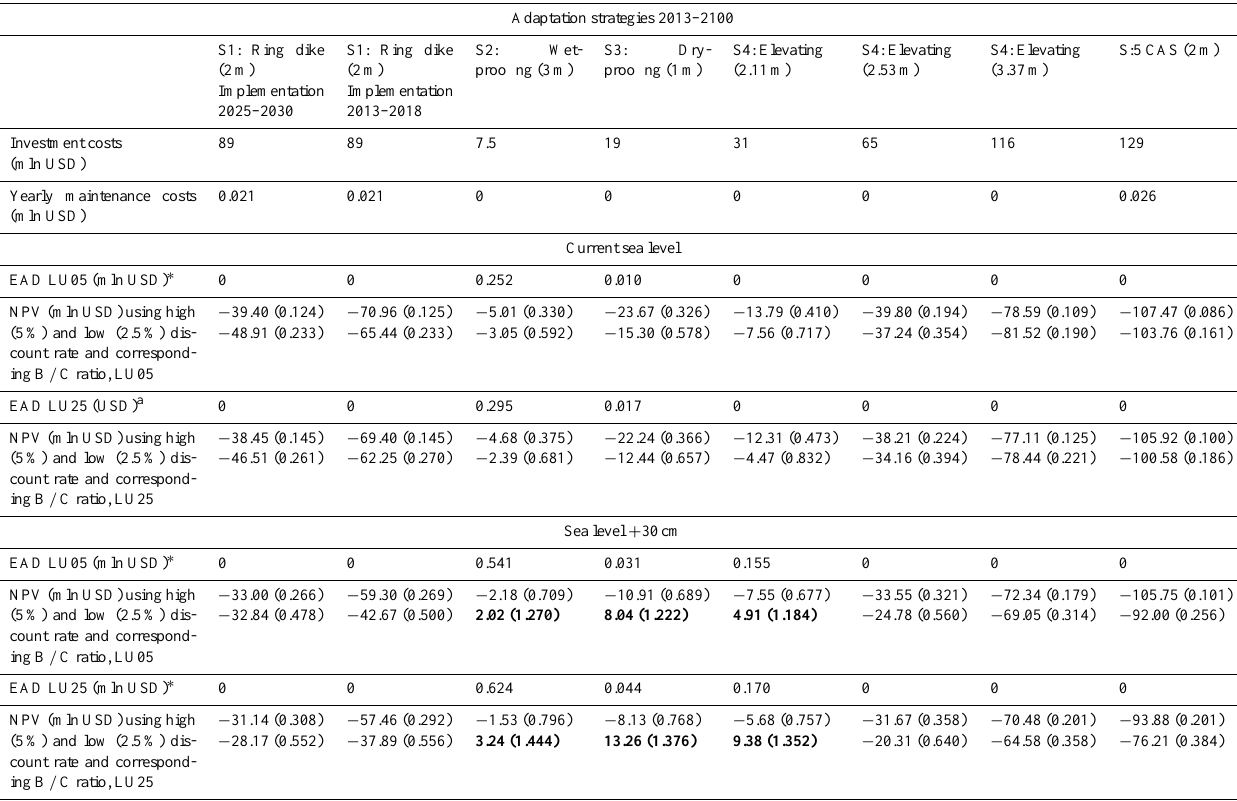
Table 3. Total costs, EADs and NPVs in USD million and BCA ratios for different flood management